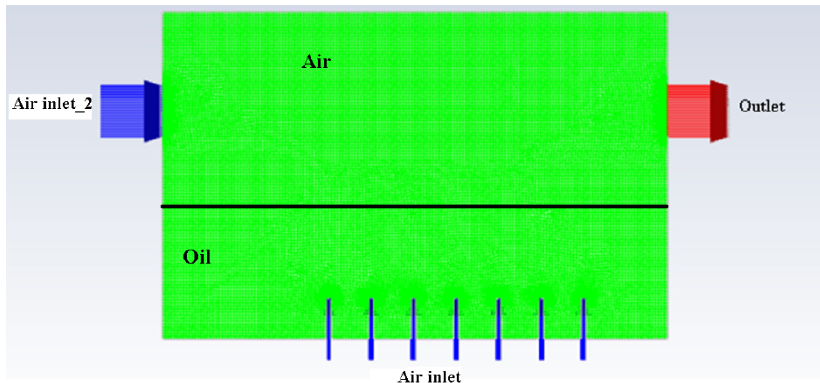
Figure 4. Naming of boundary conditions of atomisation chamber.